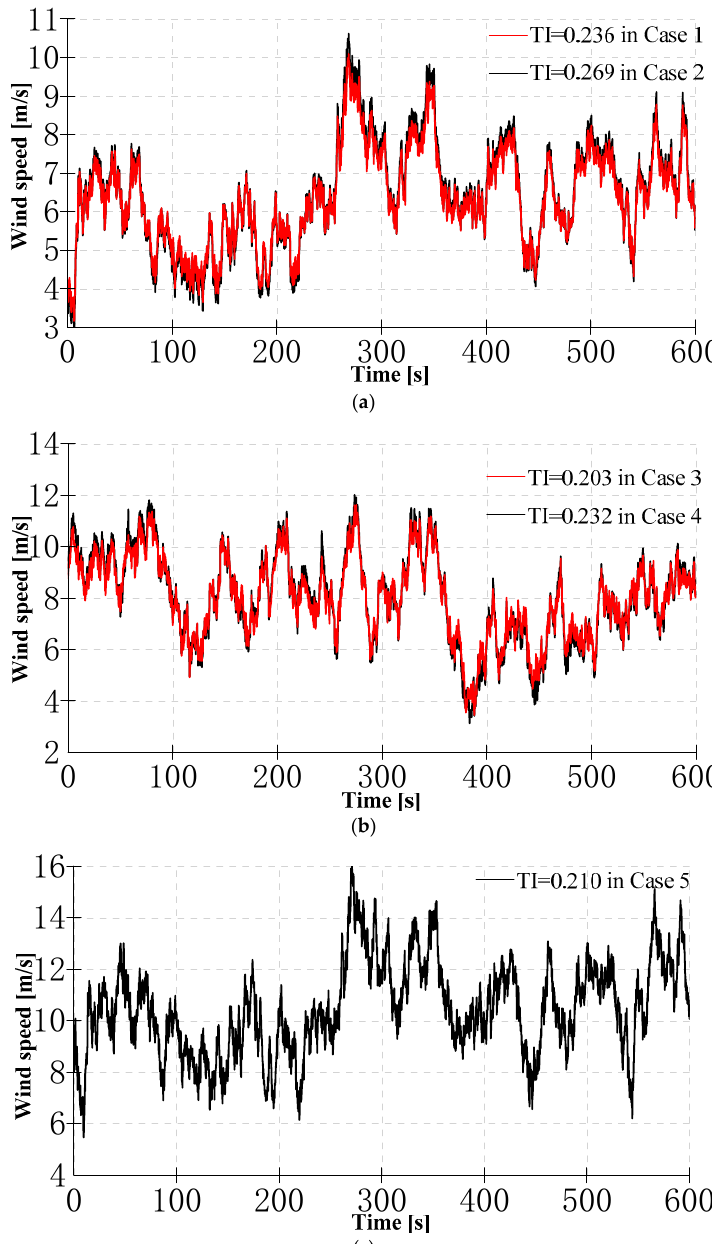
Figure 4. Time dependence of the wind speed for: ( a ) Cases 1 and 2; ( b ) Cases 3 and 4; and ( c ) Case 5.